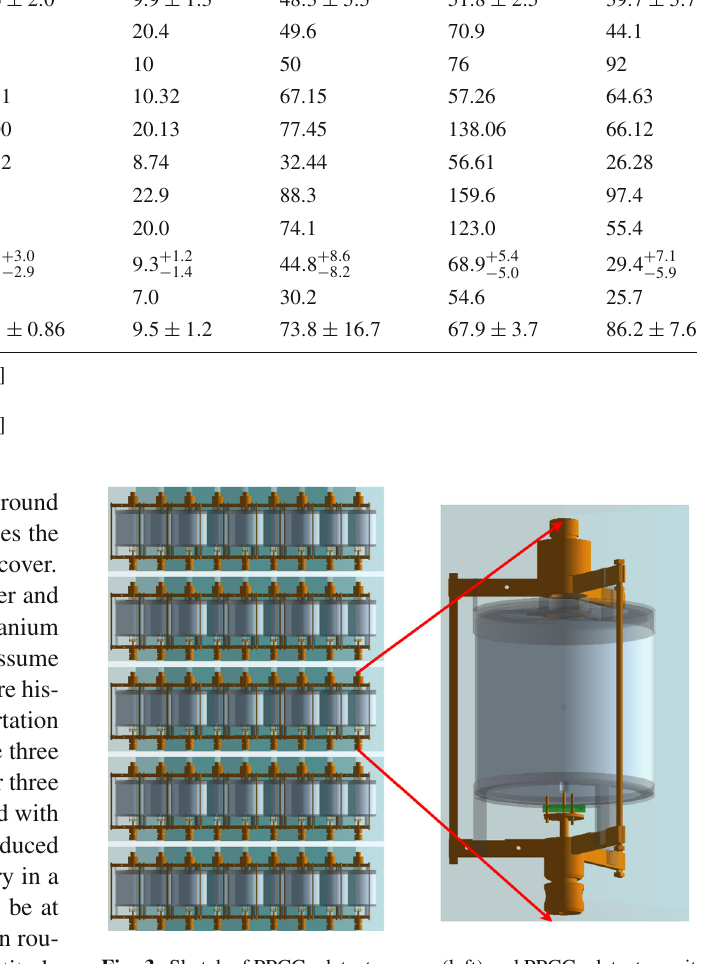
Under the above assumptions, the simulated background ratesinthelow-energyrange(2–4keVfordarkmattersearch) and around 2039 keV (energy of neutrinoless double beta decay of 76 Ge) are 7 . 17 × 10 − 2 counts per keV per tonne per year (cpkty) and 1 . 82 × 10 − 3 cpkty, respectively. The CDEX-100 experiment aims at constructing a germanium detector array with ultra-low background rates, which should be less than 3650 and 0.1 cpkty for the 2–4 keV and around 2039 keV energy regions, respectively. The background con- tribution from copper can be ignored for dark matter search, while it is 2% of the total background budget for neutrinoless double beta decay research. The contribution of 57 Co